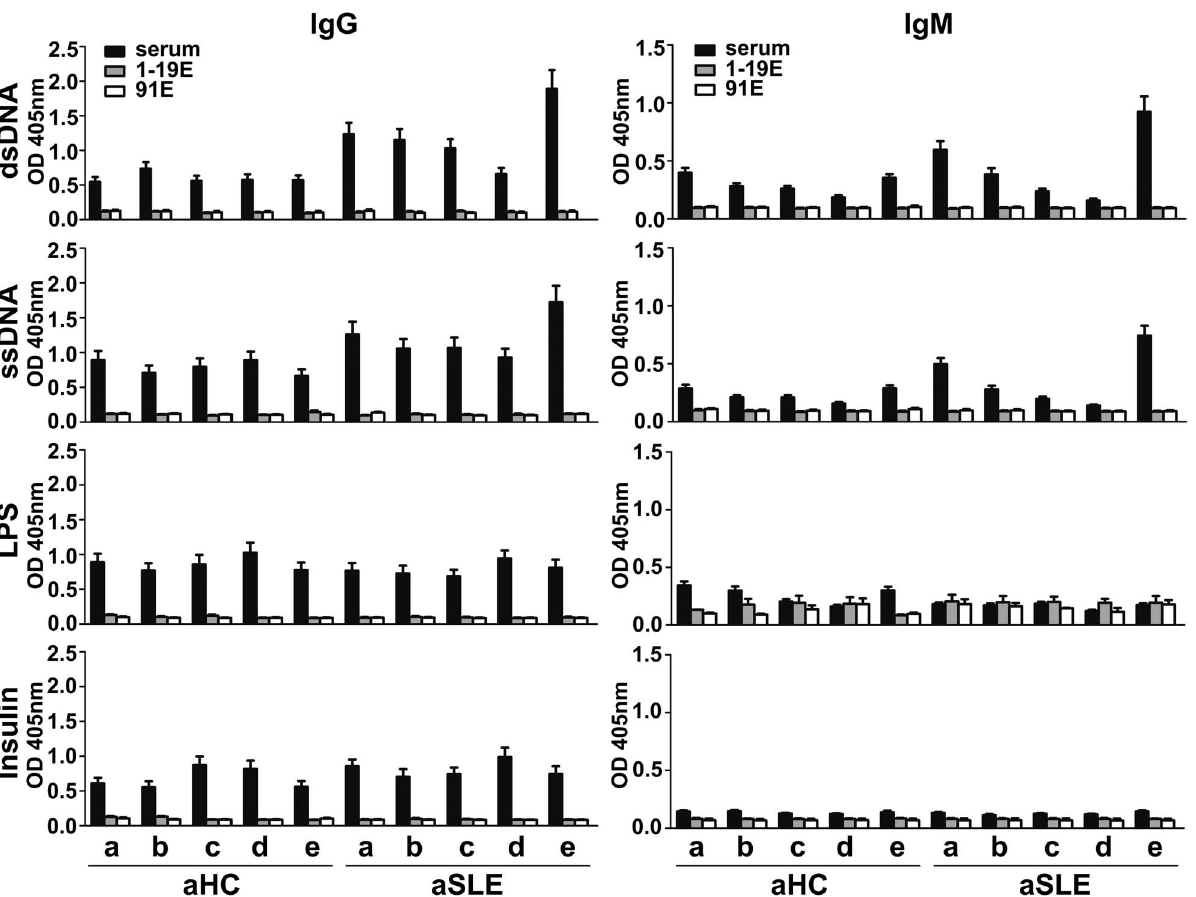
Figure 7. Polyreactivity test by ELISA. dsDNA, ssDNA, LPS or insulin was coated on microtiter plates as described in Materials and Methods. Sera (1:100 dilution) and Abs purified from the H3 1–19 or H3 1–19 K9me beads (1:200 dilution) were tested. KT47 anti-human IgG or KT16 anti-human IgM Ab was used as the primary Ab and HRP-conjugated goat anti-mouse IgG was used as the secondary Ab. a, IgG(1–19 low 91 low )IgM(1–19 high 91 high ); b, IgG(1–19 low 91 low )IgM(1–19 high 91 low ); c, IgG(1–19 low 91 low )IgM(1–19 low 91 high ); d, IgG(1–19 low 91 low )IgM(1–19 low 91 low ); e, IgG(1–19 high 91 x )IgM(1–19 x 91 x ). 1–19E, Abs eluted from the H3 1–19 beads; 91E, Abs eluted from the H3 1–19 K9me beads. Data are expressed as mean + SEM. The results are representative of two separate experiments.